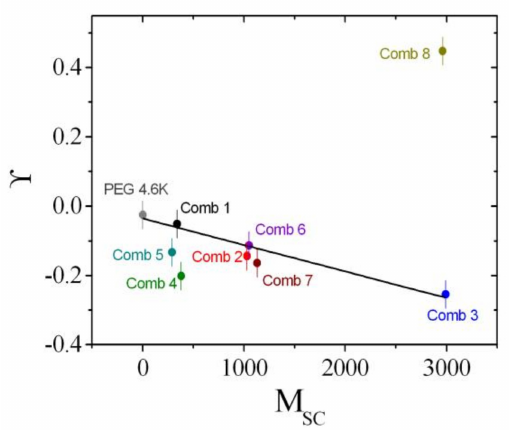
Figure 11. The sensitivity of the saddle splay modulus, ˆ Ξ , as a function of the side chain molar mass, M SC . The values are determined from the phase diagram measurements (i.e., the minimum amount of surfactant, (cid:101) γ ). The line is a guide for the eye that was fitted to the series: polyethylene oxide (PEG), Comb 1, 2, and 3.